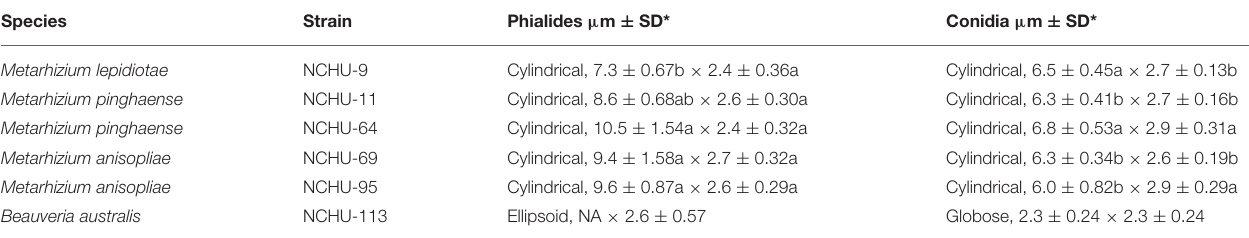
TABLE 2 | Morphological observations of six promising entomopathogenic fungal isolates.